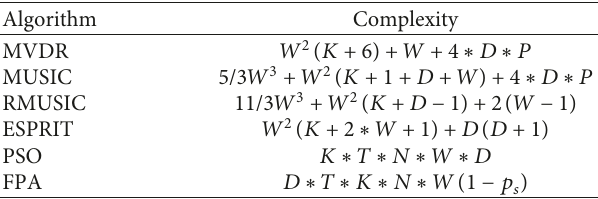
Figure 24: Probability of resolution for the source at 34 degrees. Table 4: Computational loading